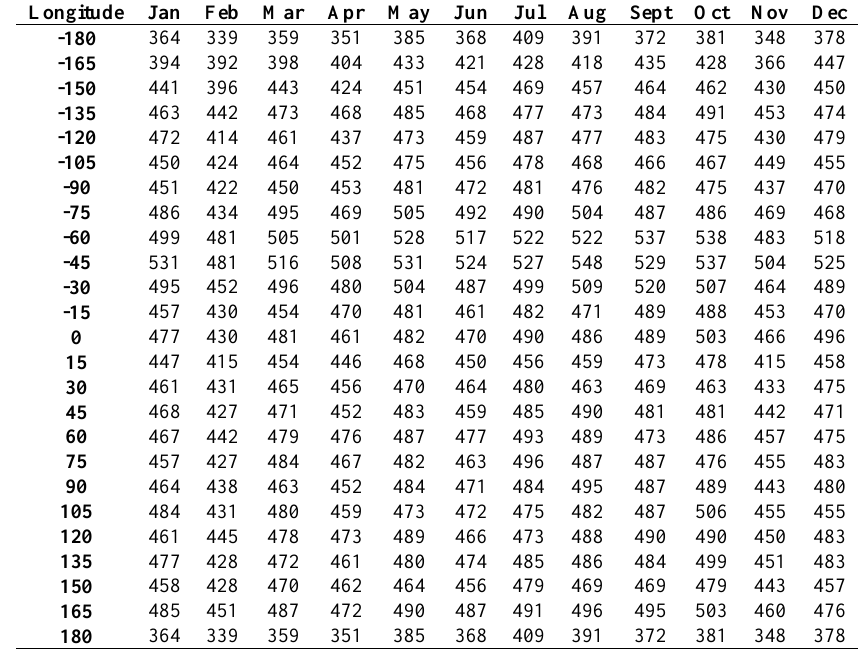
Table 2. Number of DMSP orbits per month in each longitude sector for the full DMSP EPB database 1989–2004.